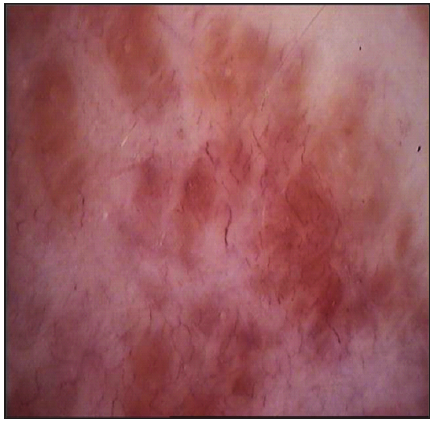
Figure 4: Videodermoscopic features: round to oval yellow-brown lesion with absence of white Wickham